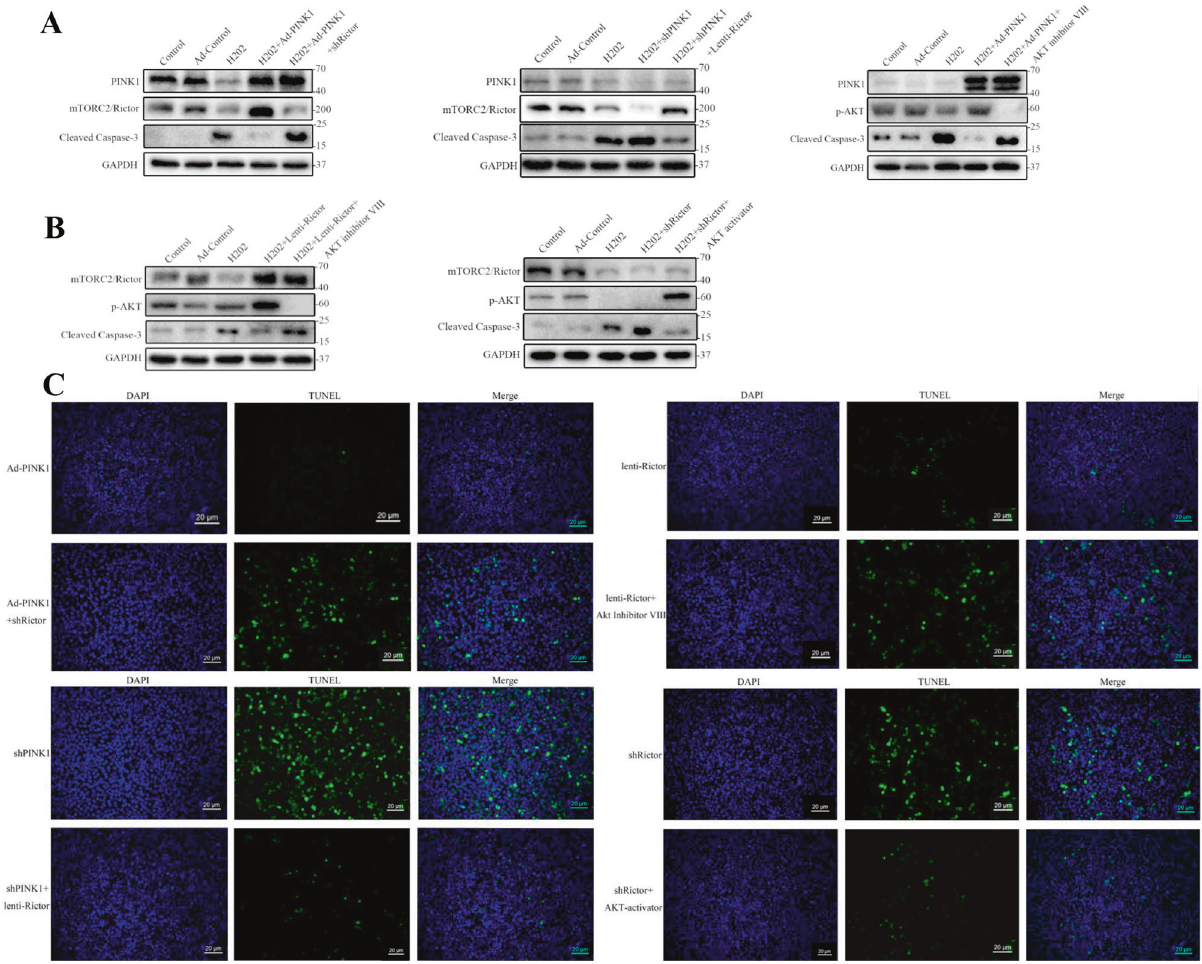
Fig. 5 The relationship between the PINK1/mTORC2/p-AKT pathway and apoptosis. A In the H 2 O 2 -induced cell model, overexpression of PINK1 followed by knockdown of Rictor or inhibition of AKT activity with AKT inhibitors VIII (10 µM), and knockdown of PINK1 with subsequent overexpression of Rictor, we further detected the expression of the apoptosis-related protein cleaved caspase-3 by WB. B Overexpression of Rictor followed by inhibition of AKT activity with AKT inhibitors VIII, and further activation of AKT after knockdown of Rictor, with cleaved caspase-3 detection by western blotting. C TUNEL assay performed in the same experimental conditions as above (green: TUNEL-positive cells; blue: DAPI; scale bar, 20